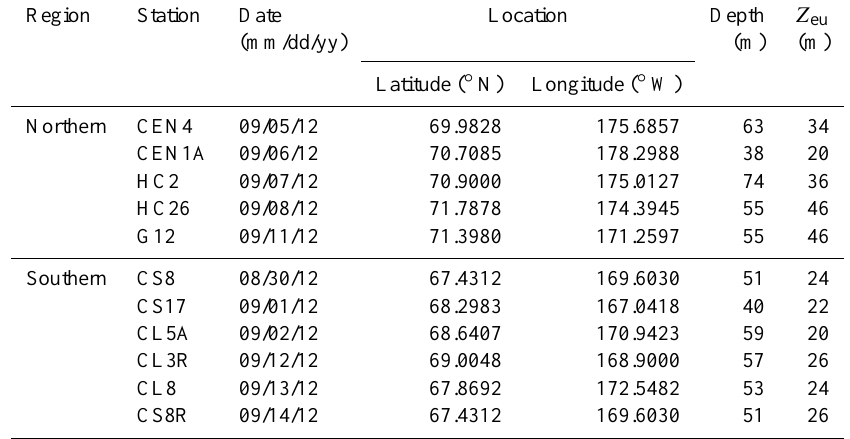
Table 1. Location, water depth (m), and euphotic depth ( Z eu ) for primary productivity stations in the Chukchi Sea in 2012.